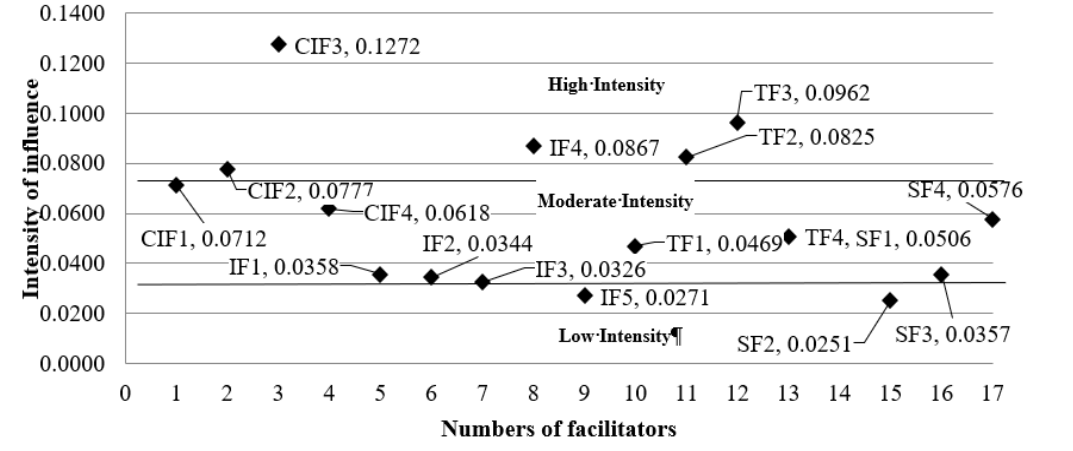
Figure 2. Intensities of facilitators in cluster